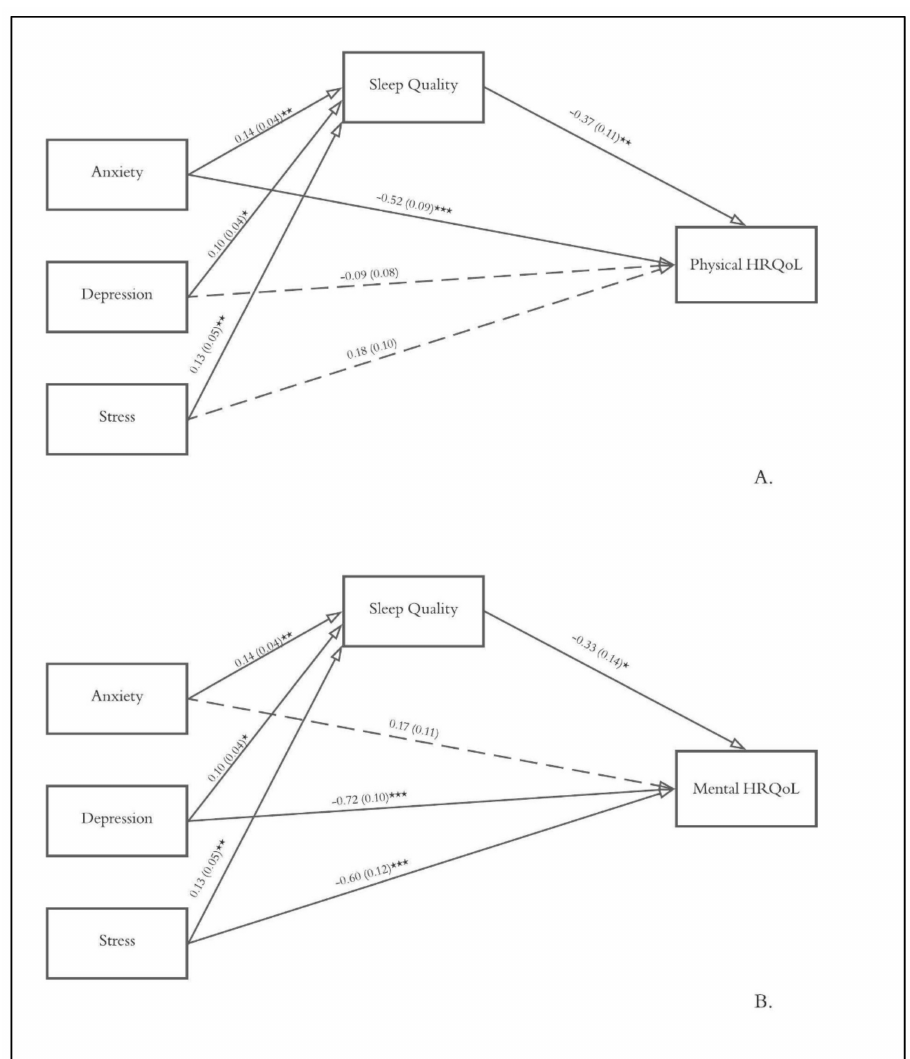
Figure 1. Examined mediation models with physical ( A ) and mental ( B ) health-related quality of life as consequents, anxiety, depression, and stress as antecedents, and sleep quality as mediator. Unstandardized path coefficients with standard errors are reported. Significant paths are represented with solid lines, while non-significant ones are represented with dashed lines. * p < 0.05; ** p < 0.01; *** p <